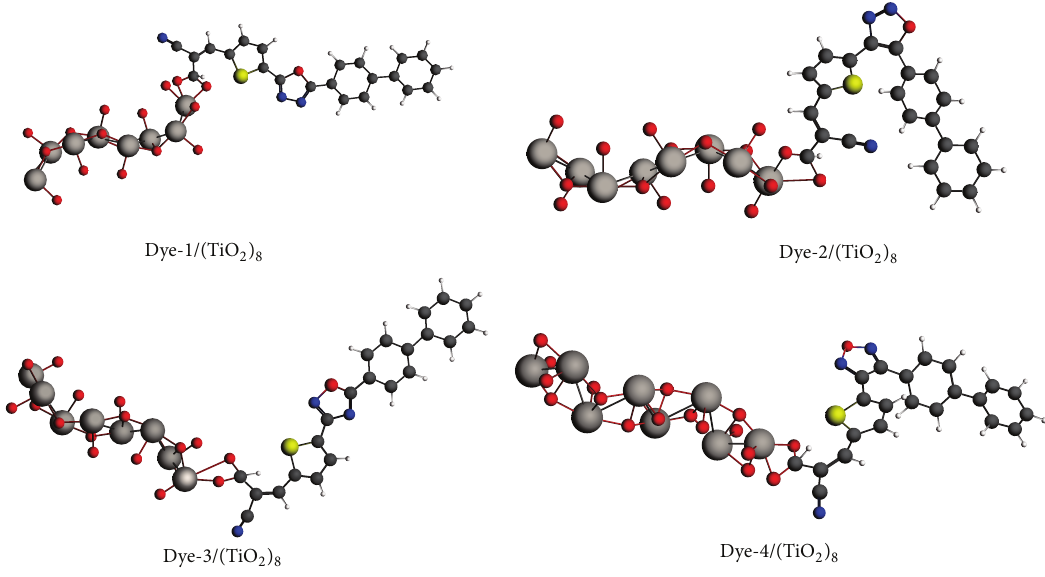
Figure 4: The model of systems 1–4 with (TiO 2 ) 8 .